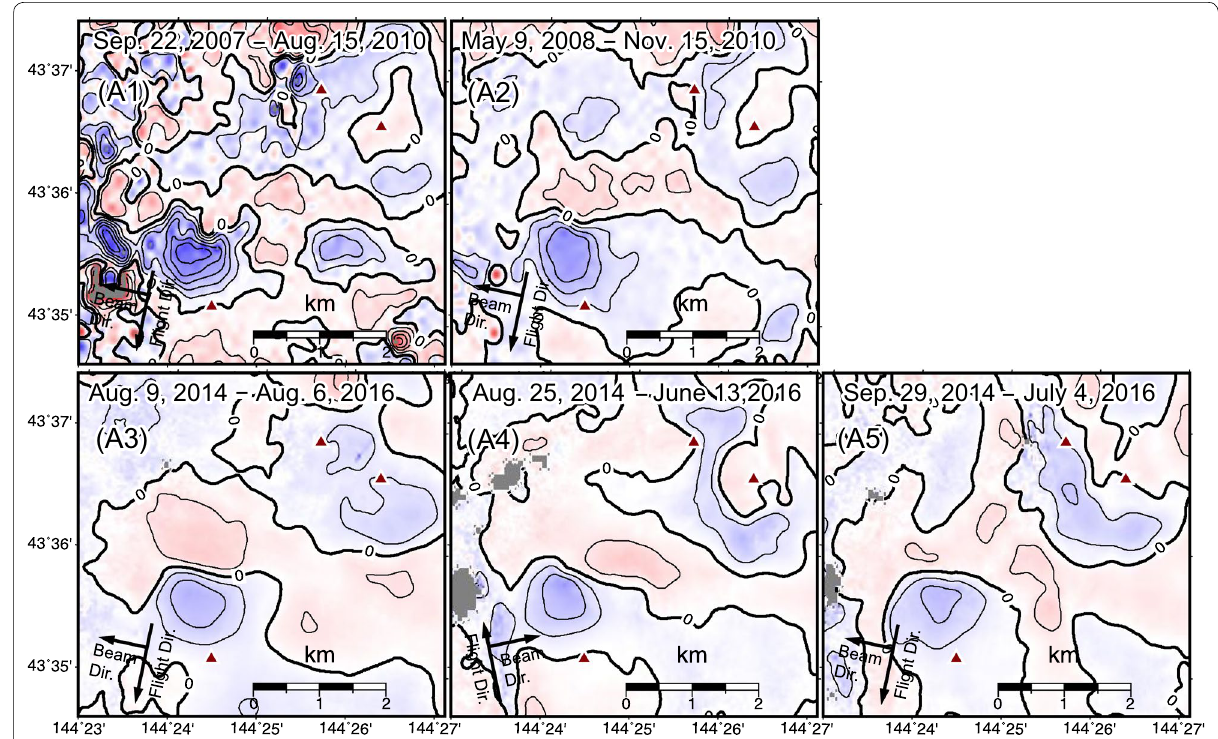
Fig. 7 High-pass-filtered (7-km cutoff) close-up view of unwrapped interferograms around the center of the deformation dome. Each number indi- cates the InSAR pair in Table 1. Red triangles indicate major lava domes belonging to the Atosanupuri volcanic complex. Contour interval is 0.5 cm. Lower right : Topography of the Atosanupuri volcanic complex. Red dotted lines show the area of a small valley (or basin) between lava domes in the topography. Small white circles show fumaroles. The target area is shown in Fig.